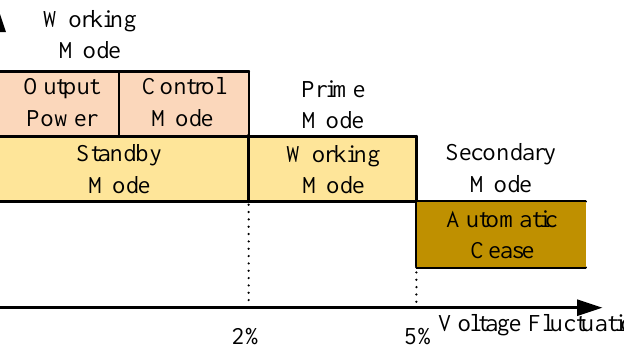
Figure 2. Hierarchical control strategy of DC microgrid.